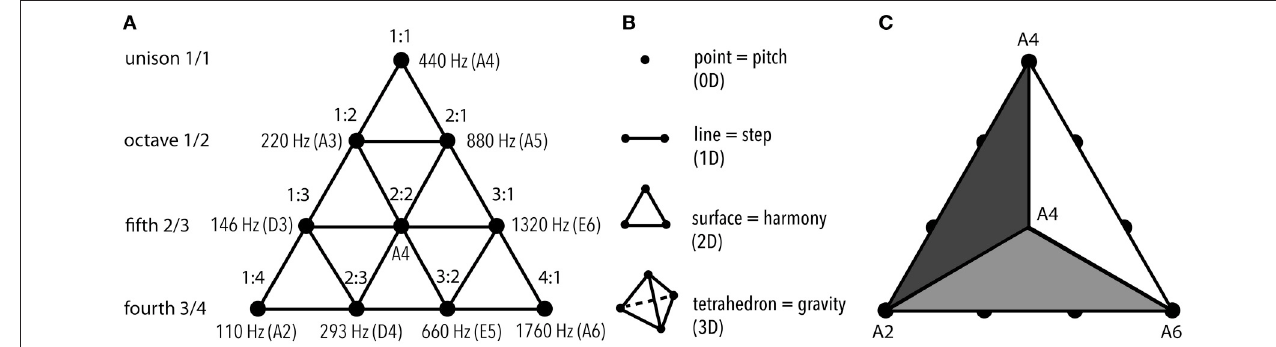
Figure 1 | Tetraktys (the “fourness”): the geometric representation of harmonicity of “4th.” (A) Musical aspect of tetraktys. On the left, each row is assigned a value that expresses the ratio of the string required for production of a perfect musical interval. Numbers 1, 2, 3, and 4 follow one another sequentially. Each row contains intervals of the designated type. On the right, the tetraktys diagram is combined with the lambdoma matrix (Bruhn, 2005, p. 67) that was associated with Pythagorean teaching in Ancient Greece (Hero and Foulkrod, 1999). The lambdoma ratios are applied to the frequency value of A4 (440Hz) taken as 1:1, producing A, D, and E—the unmutable (hestote) tones that comprised the skeleton of the Ancient Greek musical system. Obviously, the harmonic aspect of tetraktys determined the tonal organization of Greek and probably earlier civilizations. (B) Spatial aspect and its melodic correspondence. Each row represented a parameter in spatial representation: 1 point indicated zero dimensions; 2 points defined line, 1 dimension; 3 points defined surface, 2 dimensions; 4 points—a 3D geometric figure. Musically, this would be equivalent in distinguishing between an isolated pitch, a melodic step produced by succession of 2 pitches, a particular harmony produced by the relations of 3 pitches, and a gravitational frame of reference generated by 4 pitches—evident if to look at pitch values at any of the sides of the tetraktys in (A) . (C) Centripetal gravity encoded in tetraktys. The configuration of 10 points that comprise the tetraktys can represent 3D by implying 4 triangles. Then, their “corners” correspond to the same octave-equivalent pitch, indicating that the tetraktys is “tuned” to a certain tone (A)